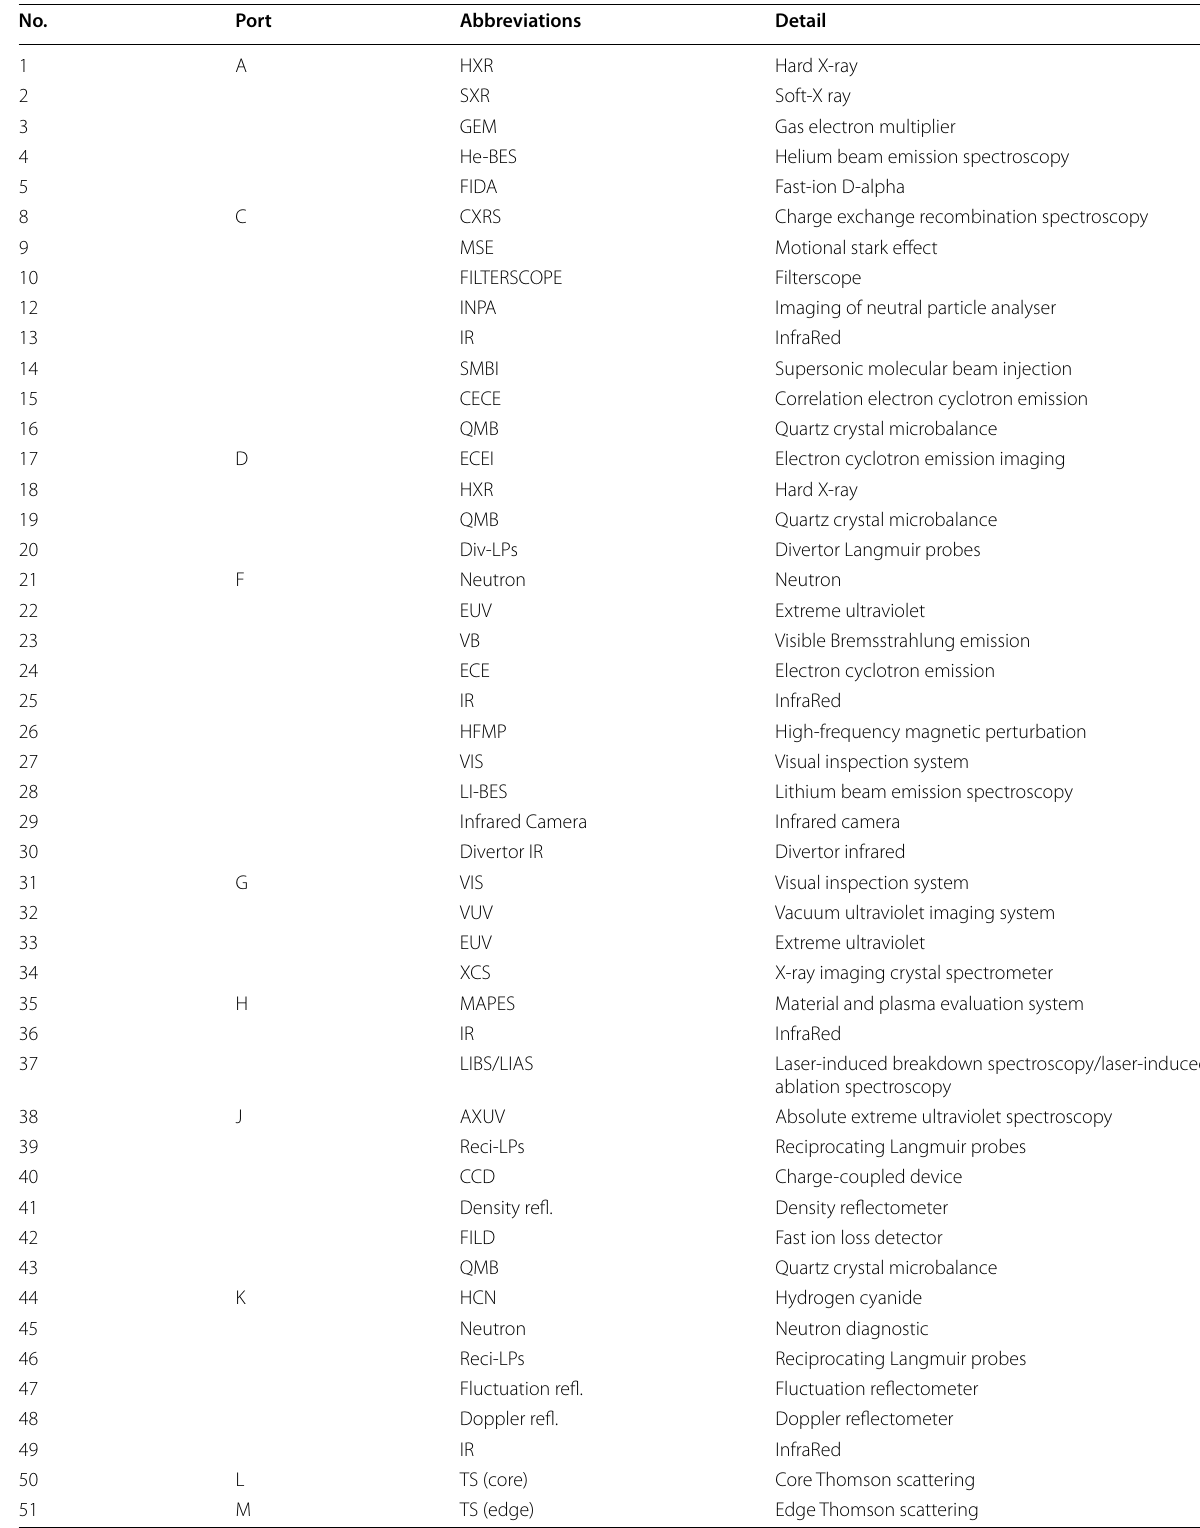
Table 2 The diagnostic systems in EAST